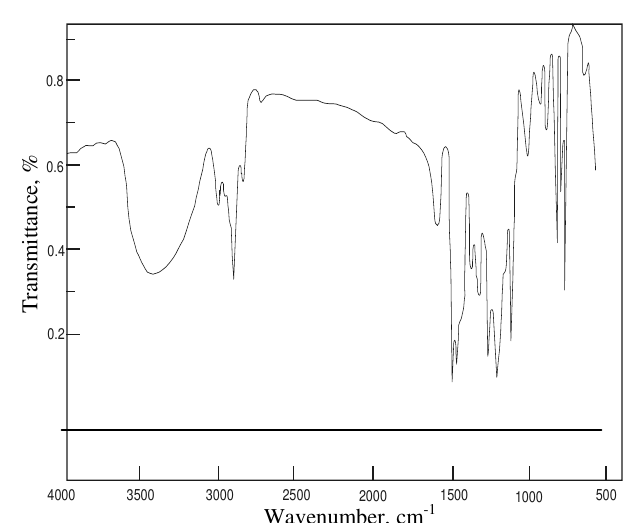
Figure 1. FTIR-spectrum of Phenol - formaldehyde novolac.